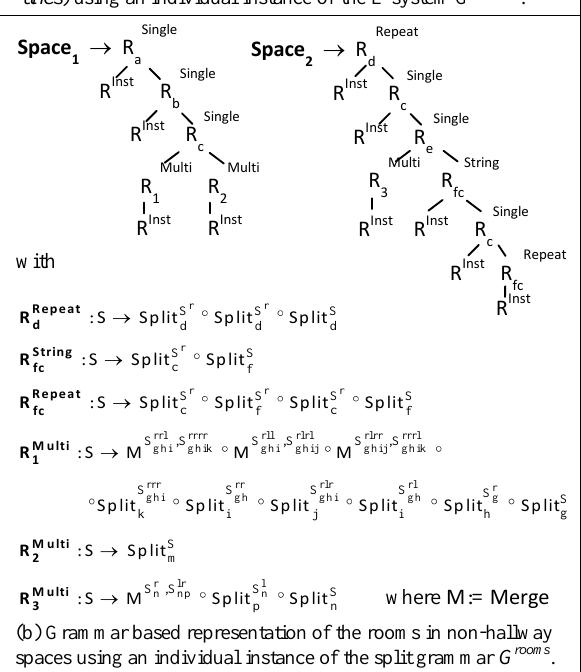
Figure 3. Real floor plan and its grammar-based